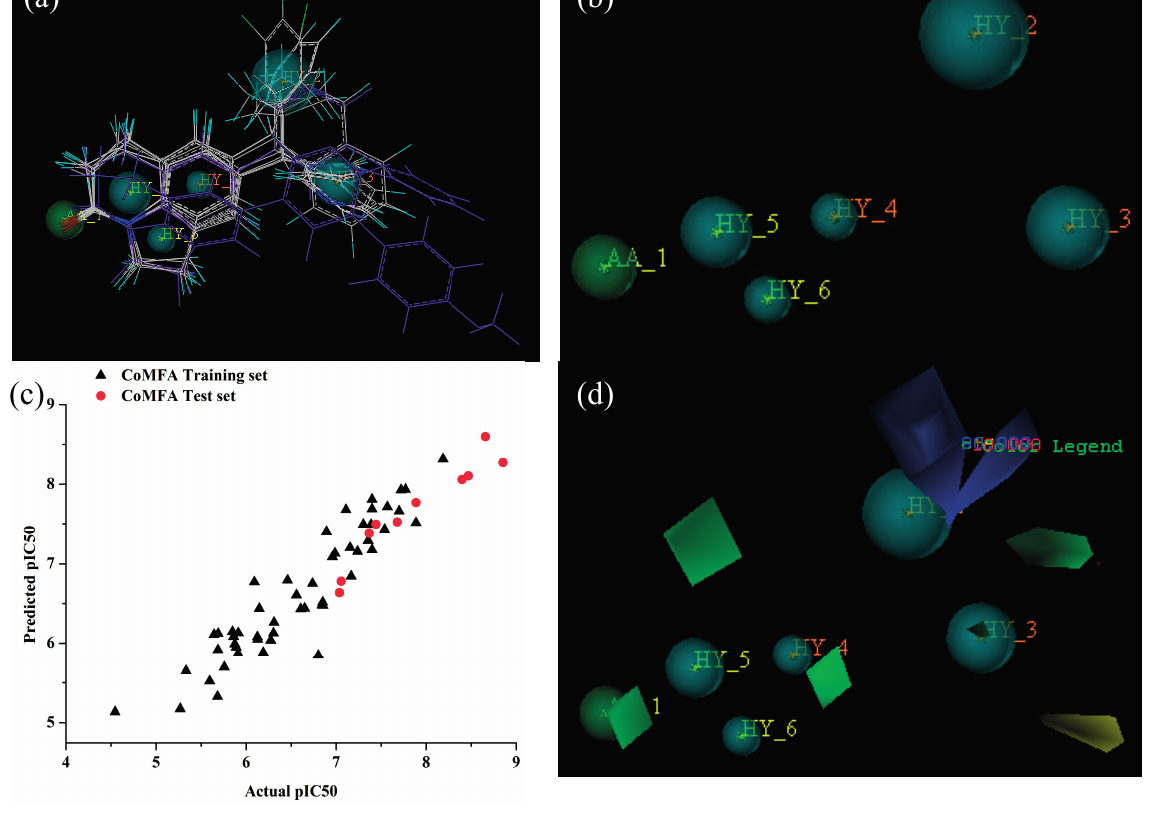
Figure 1. The results generated using GALAHAD modeling method. ( a ) The alignment of 62 CYP11B1 inhibitors; ( b ) The best pharmacophore model generated by the GALAHAD method; ( c ) Observed versus predicted pIC 50 values derived from CoMFA of both training and test sets; ( d ) CoMFA contour maps for the best pharmacophore